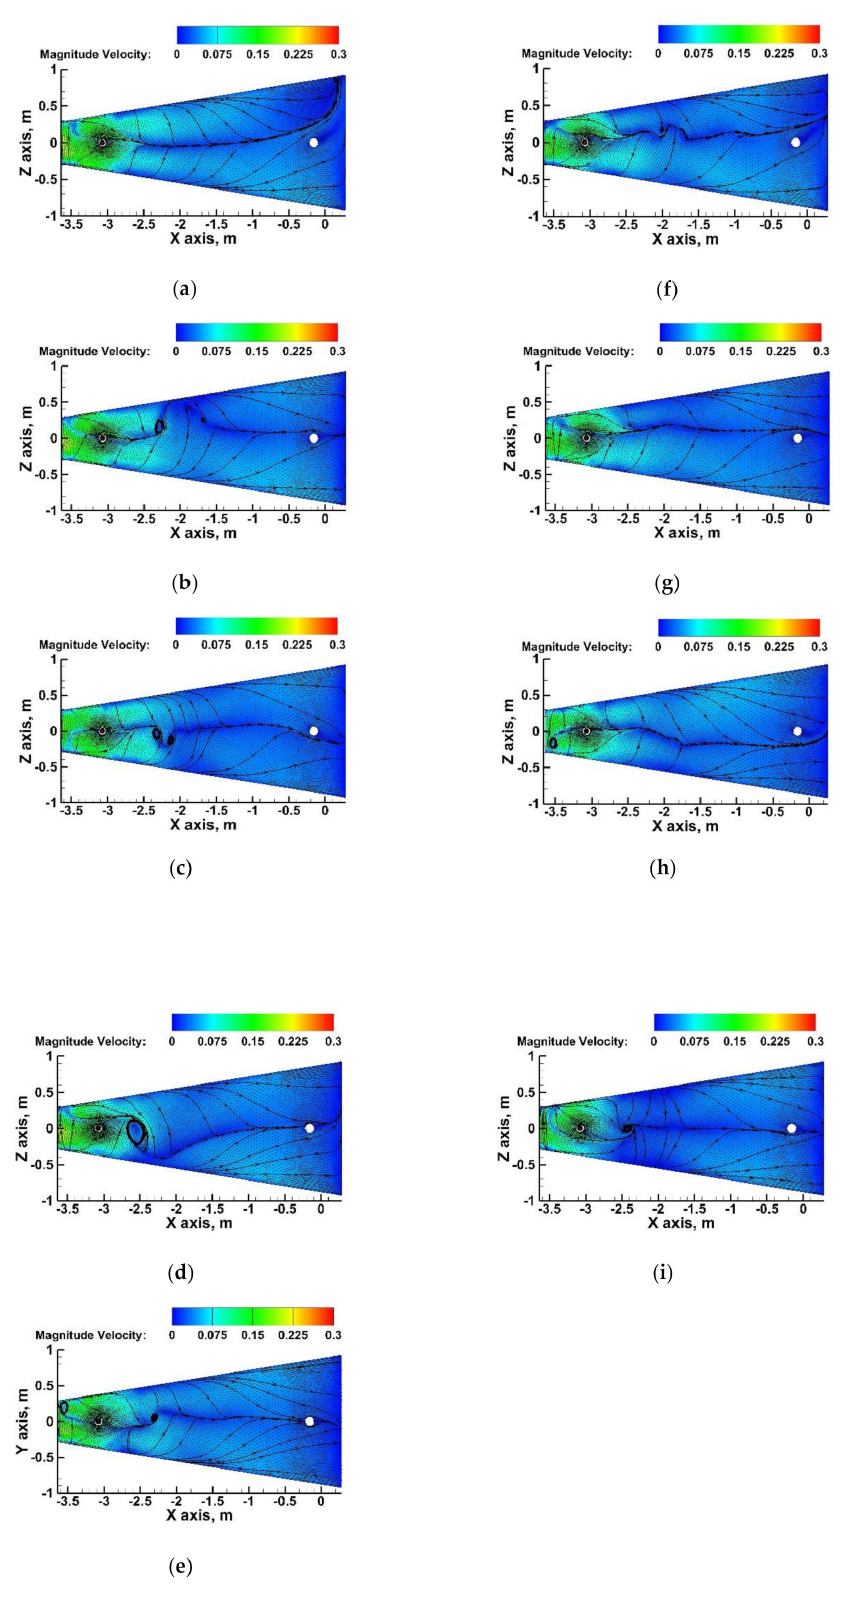
Figure 7. Behavior of liquid steel flow near the tundish flux-steel interface: ( a ) bare tundish, ( b ) tundish with SFC No. 1, ( c ) tundish with SFC No. 2, ( d ) tundish with SFC No. 3, ( e ) tundish with SFC No. 4, ( f ) tundish with SFC No. 1C, ( g ) tundish with SFC No. 2C, ( h ) tundish with SFC No. 3C, ( i ) tundish with SFC No.